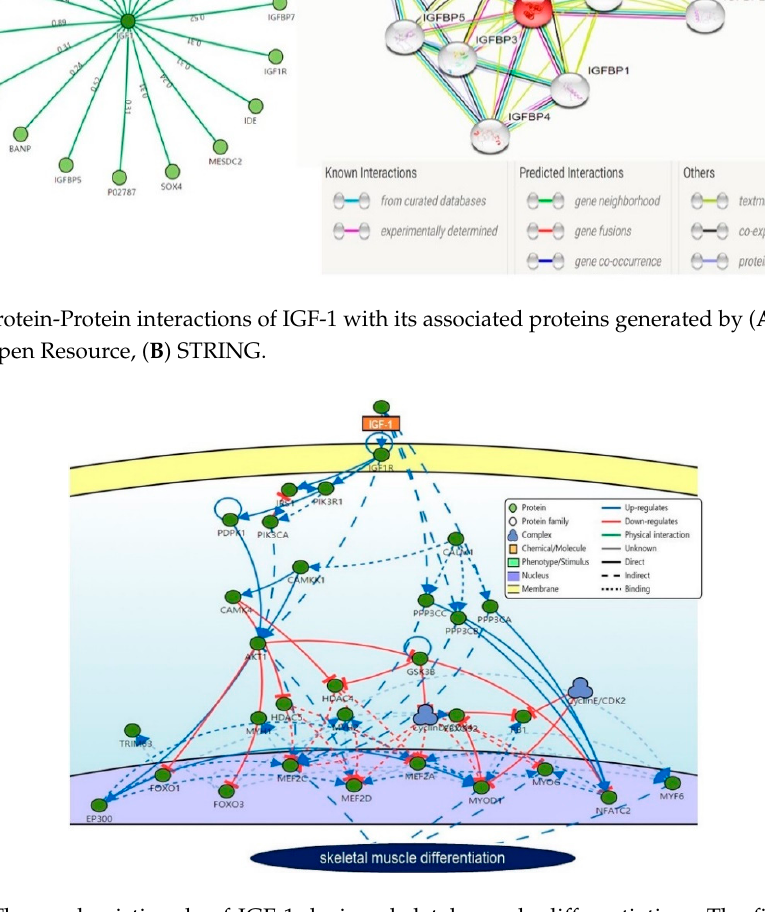
Figure 4. The mechanistic role of IGF-1 during skeletal muscle di ff erentiation. The figure shows signaling interactions during muscle differentiation as predicted by SIGnaling Network Open signaling interactions during muscle di ff erentiation as predicted by SIGnaling Network Open Resource